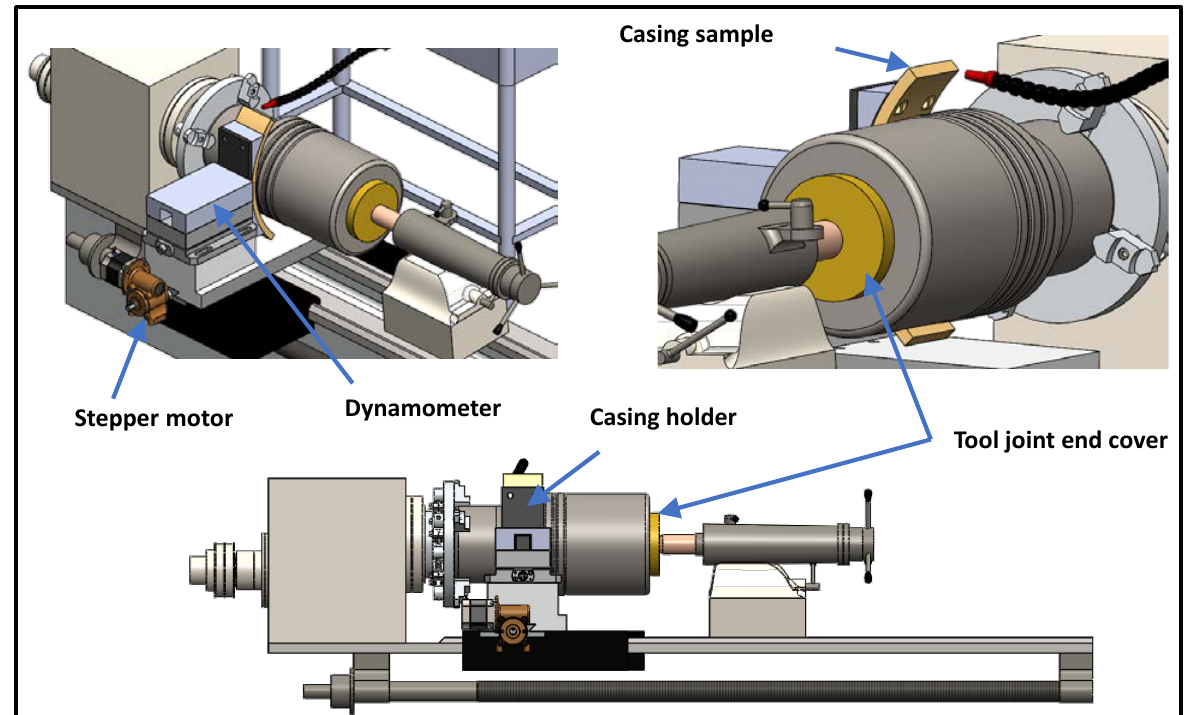
Figure 1. Three-dimensional model of the customized and modified system.